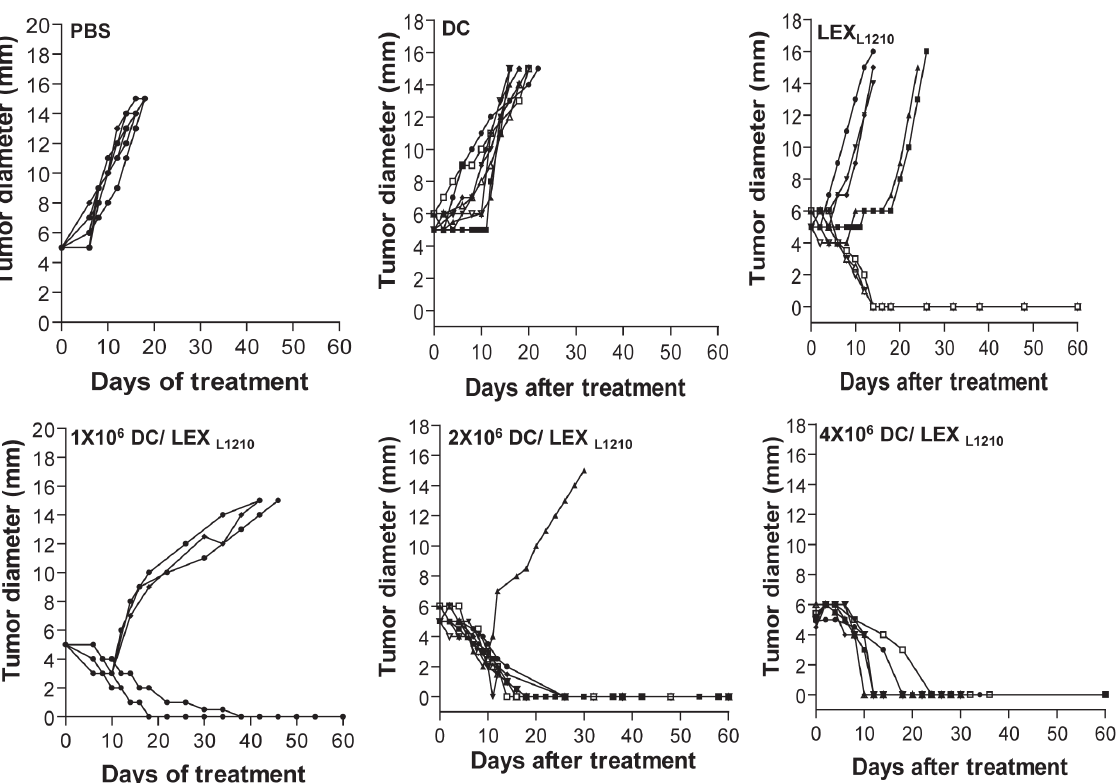
Figure 5. Therapeutic effect of LEX L1210 -pulsed DCs on established tumors. To examine the therapeutic effect on established tumors, DBA/ 2 mice (n=8 per group) were subcutaneously (s.c.) inoculated with L1210 cells (0.5 6 10 6 cells/mouse). After 5 d, when tumors became palpable ( , 5 mm in diameter), mice were s.c. immunized with L1210-derived exosomes (LEX L1210 ) and different doses of dendritic cells (DCs) pulsed with LEX L1210 (DC/LEX L1210 ) (1.0–4.0 6 10 6 cells/mouse). Animal mortality and tumor growth or regression were monitored daily for up to 10 weeks. For ethical treatment of the animals, mice were euthanized when the tumor diameter reached 1.5 cm. Experiments were performed in triplicate. One representative experiment is shown.